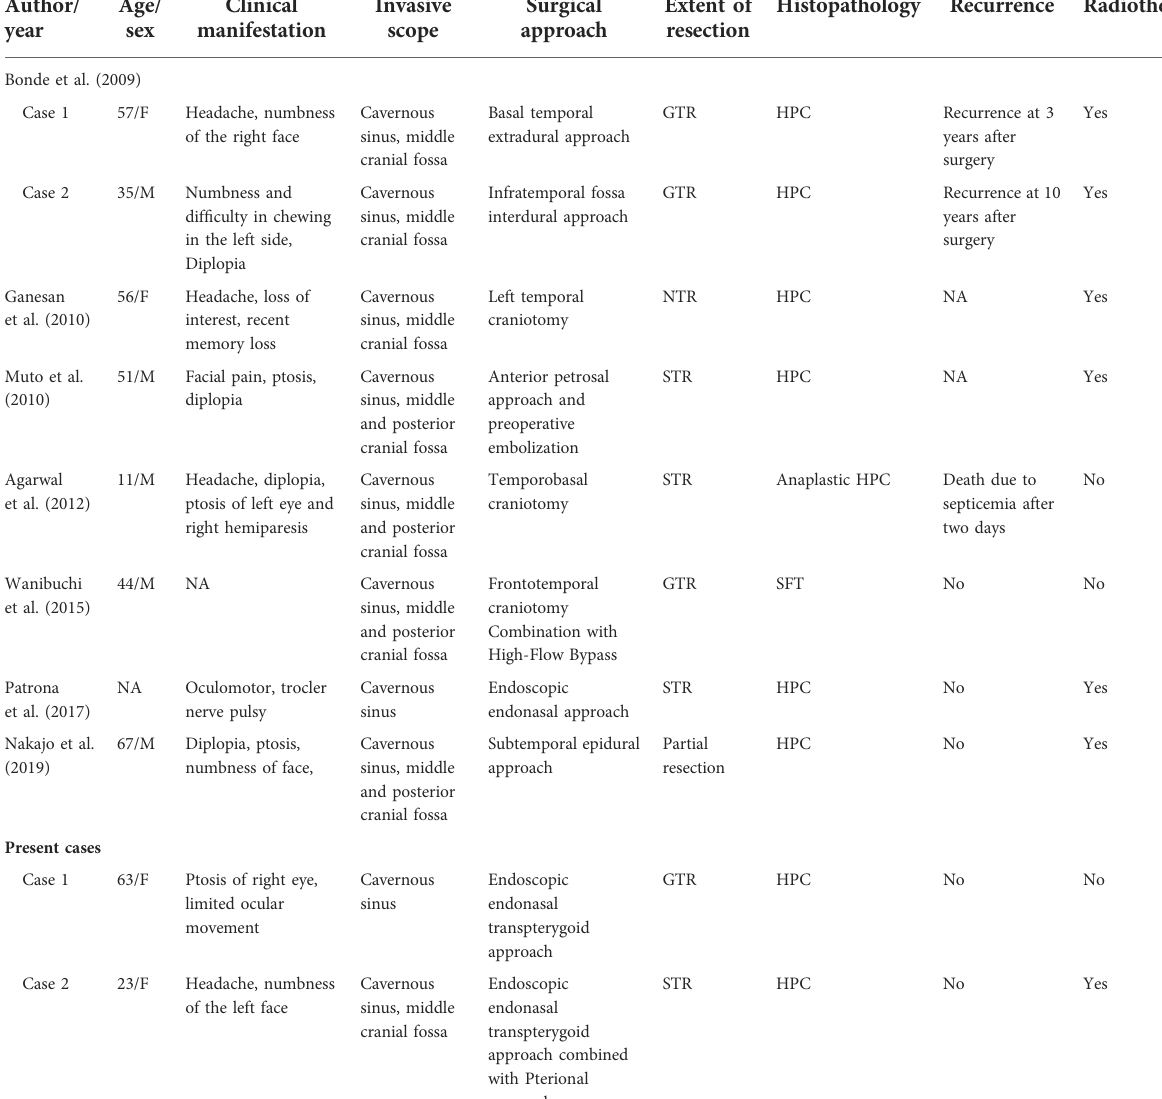
TABLE 1 Literature review of ten cases of hemangiopericytomas invading cavernous sinus. Author/